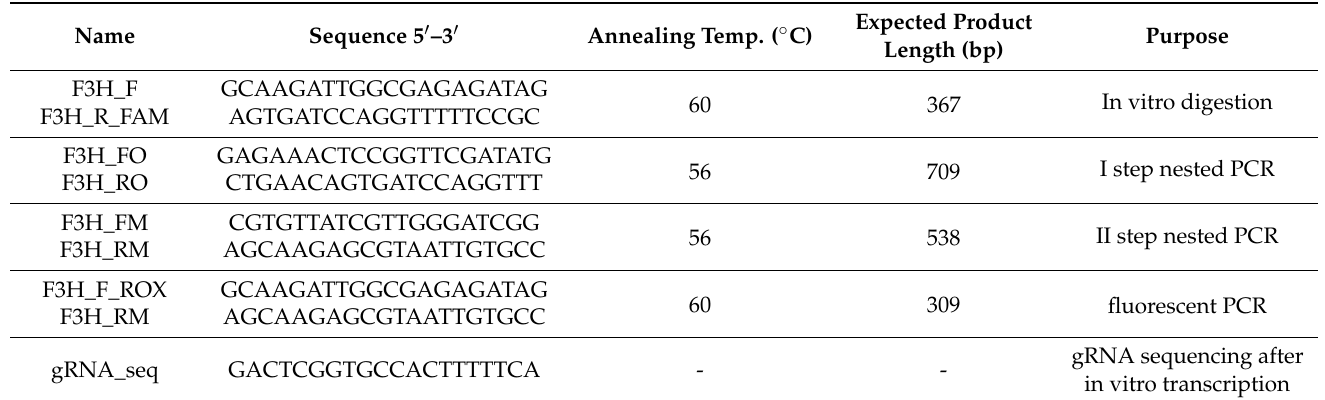
Table 2. Primers used for PCR and Sanger